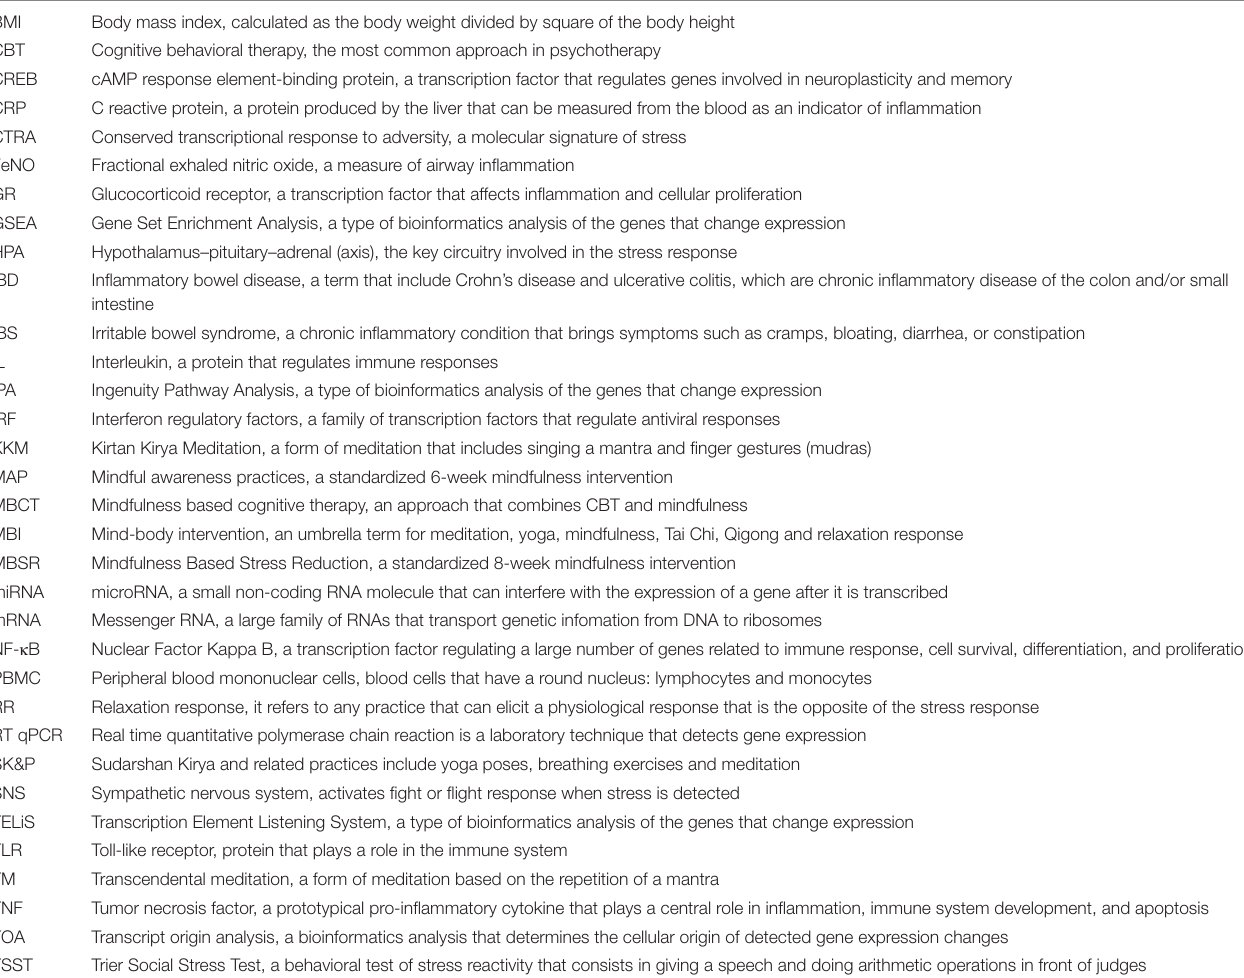
TABle A1 | Common abbreviations and their